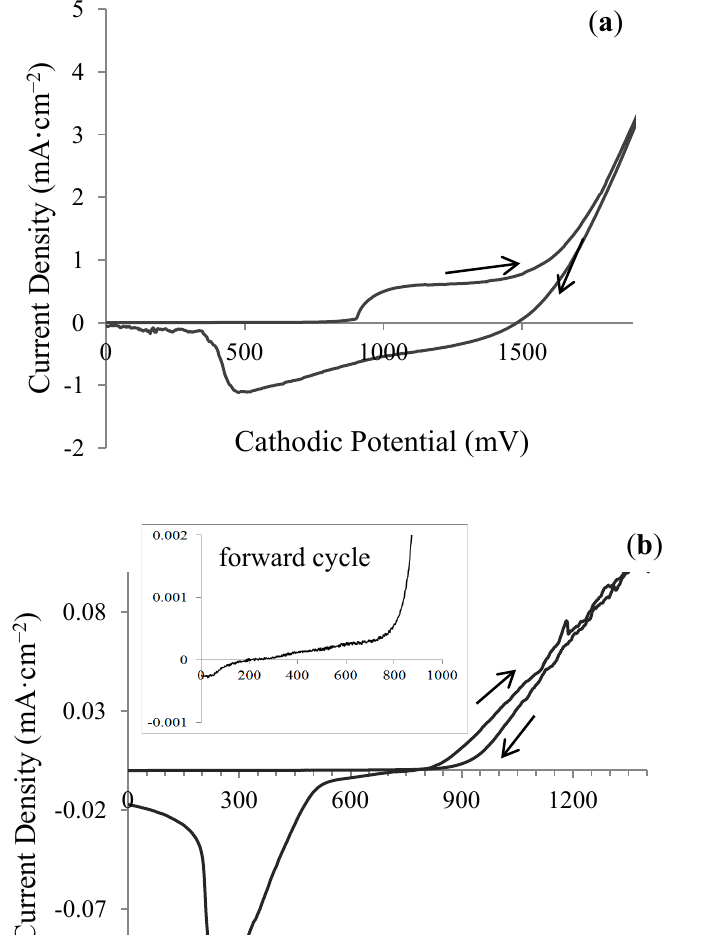
Figure 1. Typical voltammograms for ( a ) 1 M CdSO ( c ) the deposition electrolyte containing a mixture of 1 M CdSO shows the expanded forward cycle showing the crossing point at ~200